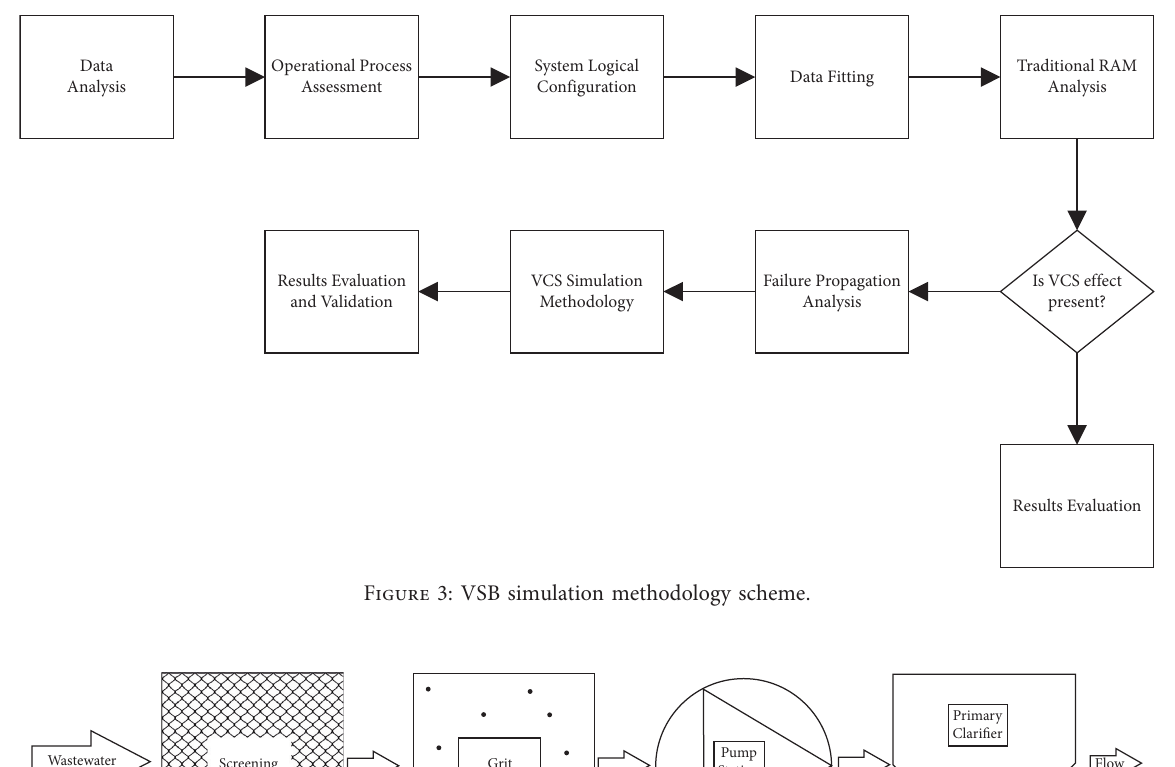
Figure 3: VSB simulation methodology scheme.